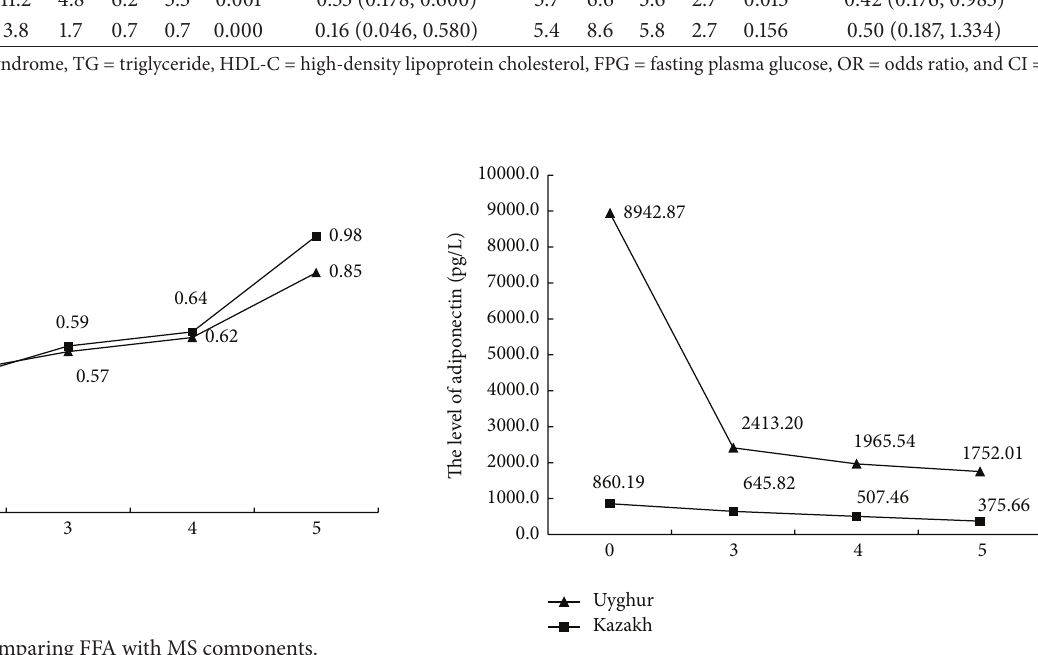
Figure 4: Comparing adiponectin with MS